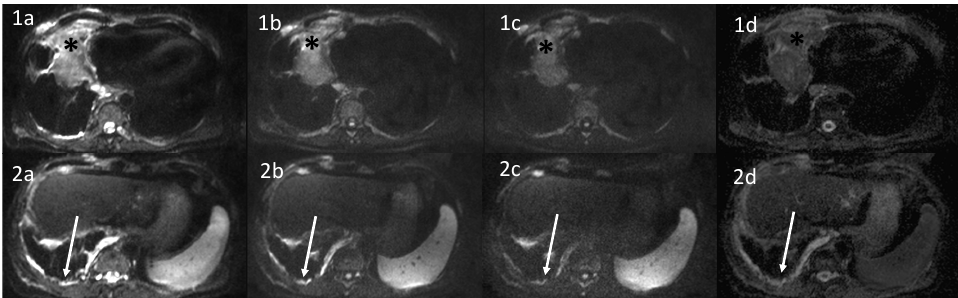
Figure 4. Diffusion Weighted Images (DWI) and Apparent Diffusion Coefficient (ADC) maps of a patient affected by MPM. Different b values were performed ( a : b = 50 s/mm 2 ; b : b = 400 s/mm 2 ; c : 800 s/mm 2 ; d : ADC map) to assess persistent areas of signal restriction. ( 1a – d ) Black asterisk: previously treated malignant pleural mesothelioma (MPM) with persistence of diffusion restriction in the anterior portion of the lesion. ( 2a – d ) Diaphragmatic and mediastinal pleural thickening with evidence of pointillism on DWI. Finally, T1-weighted fat-saturated 3D gradient echo (VIBE) sequences before and af- ter contrast injection were made. After the administration of contrast injection (0.2 mL/kg of gadoteridol (Prohance ® ; Bracco, Milan, Italy), acquisitions occurred at 40 s, 80 s, 3 min, 4:30 min and at 5 min, to assess lesions enhancement.